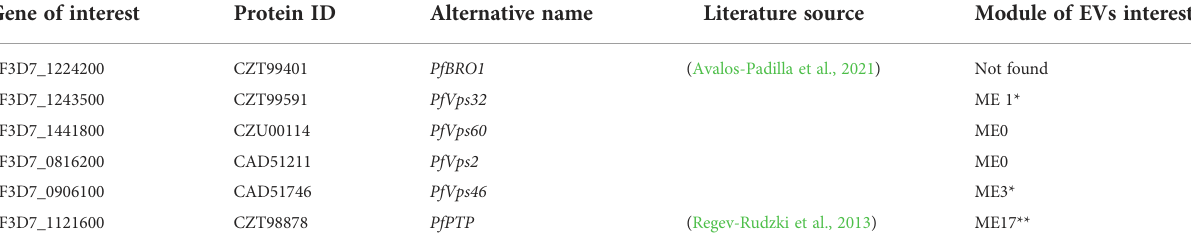
TABLE 1 Genes of interest (GOI) involved in the biogenesis and export of extracellular vesicles, (EVs) in P. falciparum